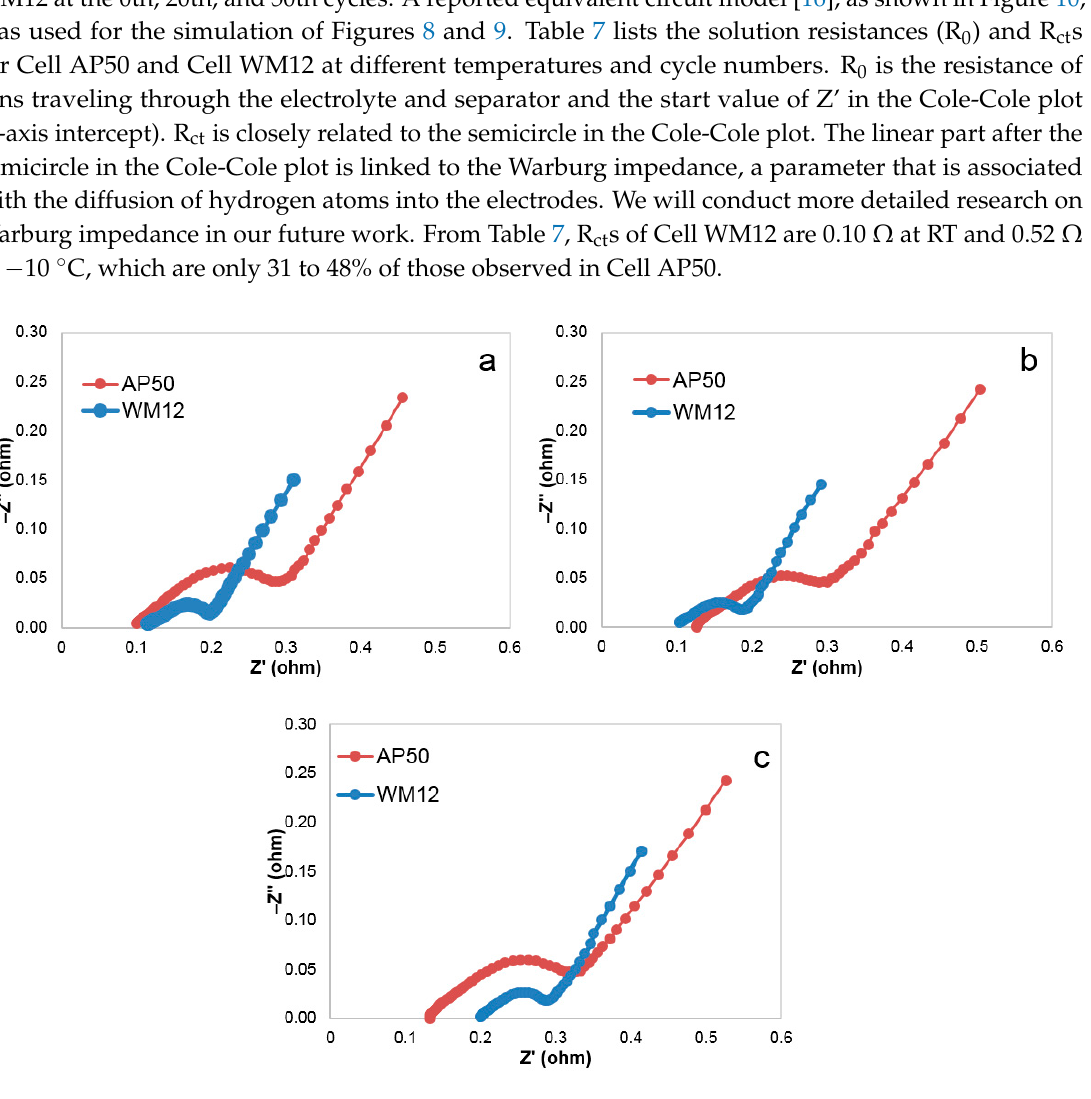
Figure 8. Room temperature Cole-Cole plots for Cell AP50 and Cell WM12 at the ( a ) 0th, ( b ) 20th, and ( c ) 50th cycles obtained at 60% SOC.